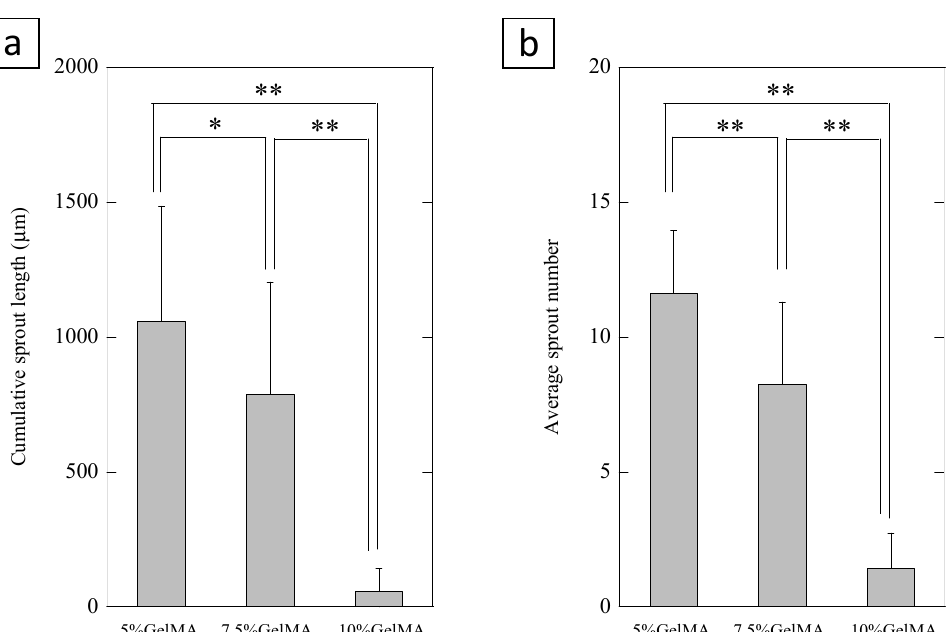
Figure 4. Three-dimensional in vitro angiogenesis of HUVEC spheroids in the different concentrations of GelMA (( a , d ) 5%, ( b , e ) 7.5%, and ( c , f ) 10%) just after polymerization of GelMA ( a – c ), and after 1 day of culture ( d – f ). Bars = 100 μ m.